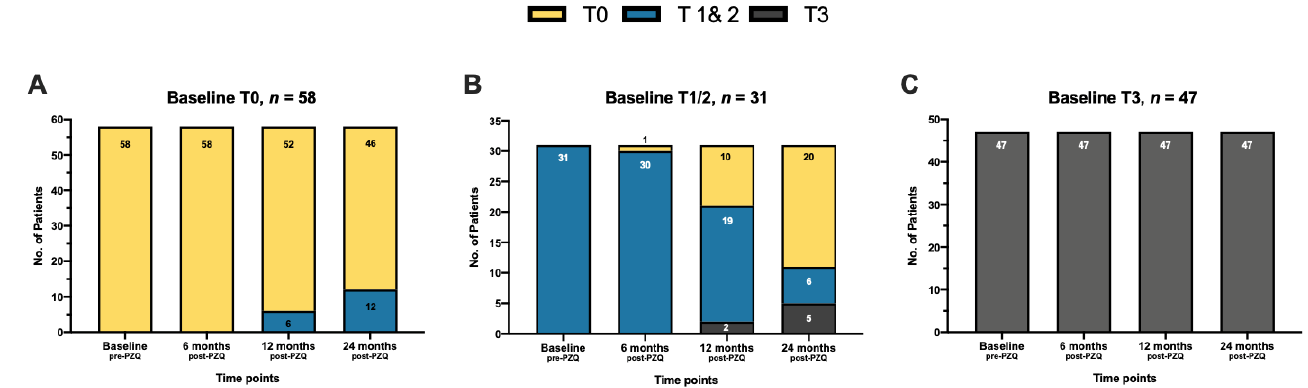
Figure 2. Dynamics of US-detectable hepatic fibrosis severity at different timepoints after PZQ treatment among the 136 patients enrolled in the prospective study. ( A ) Patients with no hepatic fibrosis at baseline (T0, n = 58). ( B ) Patients with mild hepatic fibrosis at baseline (T1/2, n = 31). ( C ) Patients with severe or typical network hepatic fibrosis at baseline (T3, n = 47). Note : Values presented are the absolute count of patients in each classification. Abbreviation : Praziquantel (PZQ)